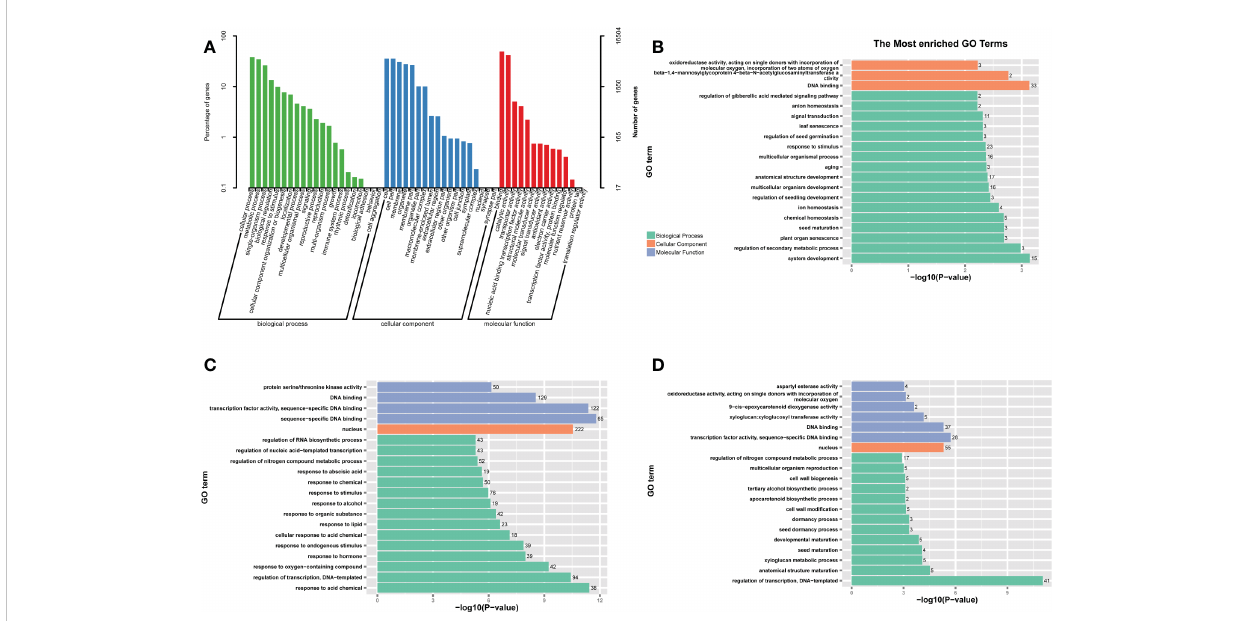
FIGURE 1 (A) Gene ontology (GO) belonging to the functional classi fi cation of all unigenes of the K. obovata seedlings transcriptome, the right y-axis indicates the number of genes in each category and the left y-axis indicates the percentage of genes. (B-D) Gene ontology (GO) enrichment analysis of differentially expressed genes (DEG) in three tissues under cold stress conditions. (B) Representative enrichment (p-value < 0.05) GO terms in (B) leaf (C) root (D) stem DEGs, three colors indicate three different categories and horizontal coordinates indicate